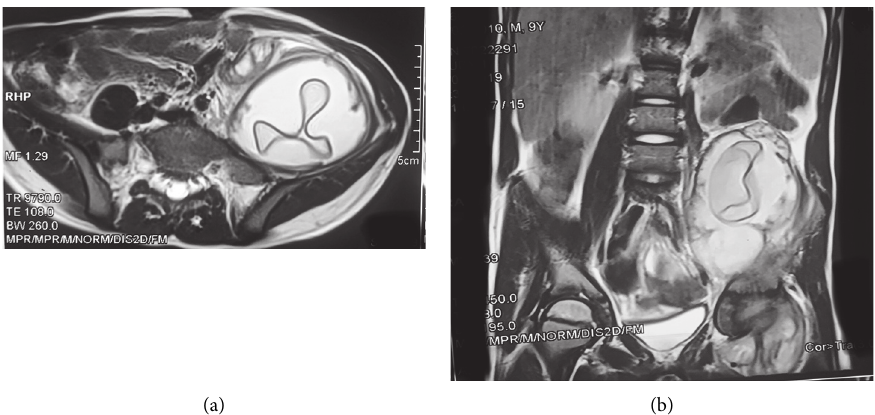
Figure 2: MRI image in transversal (a) and sagittal (b) plane showing a floating membrane of the hydatid